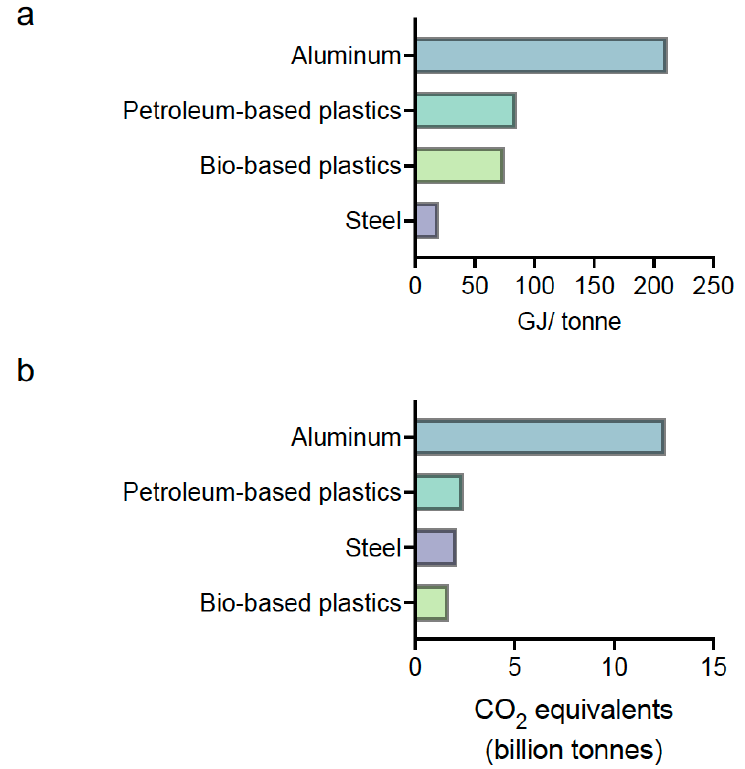
Figure 3. Integrated energy required ( a ) and global CO 2 emission ( b ) associated with lightweighting materials’ manufacturing .